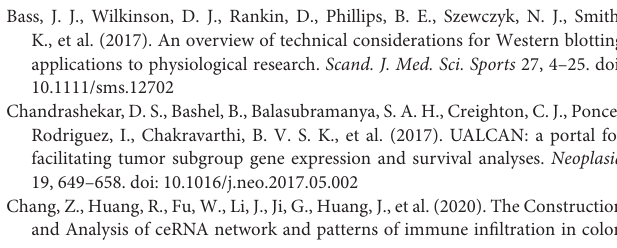
Supplementary Figure 1 | The Kaplan-Meier plotter of PPARG. Supplementary Figure 2 | GSEA enrichment analysis. Supplementary Table 1 | Clinical